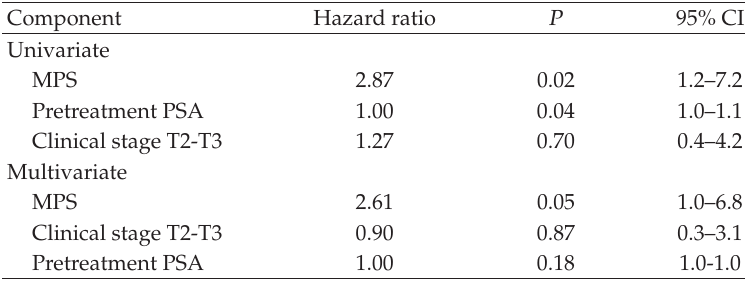
Table 2: Cox proportional hazards model analysis of the metastatic potential score and clinical predictors.